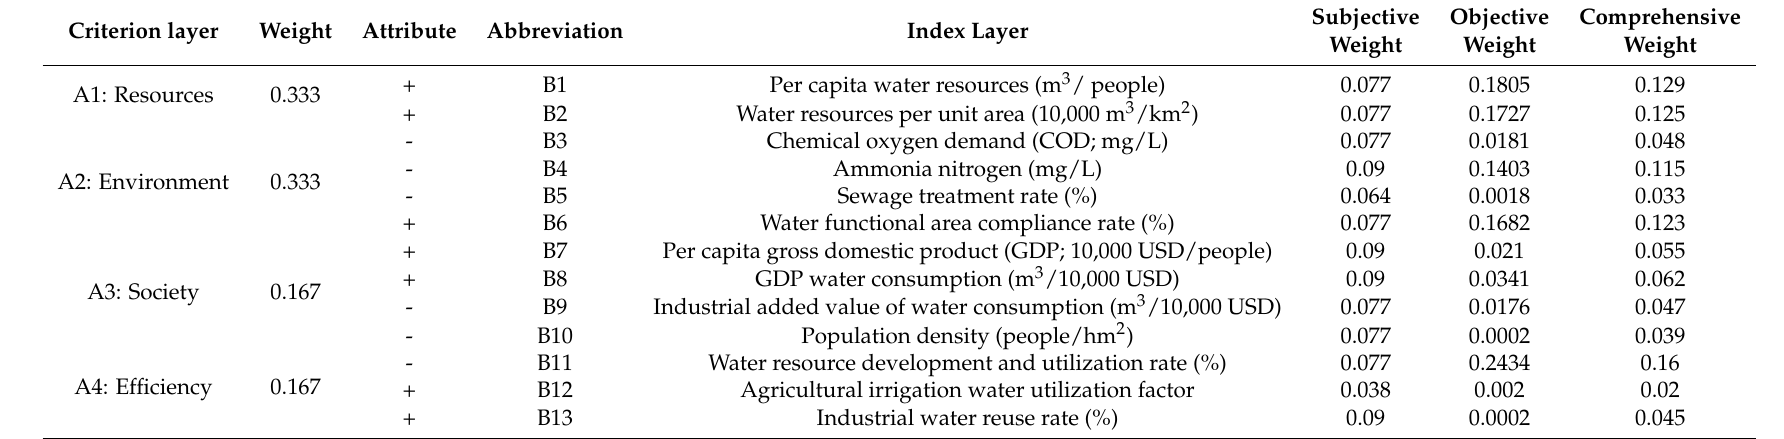
Table 2. Determination of subjective and objective